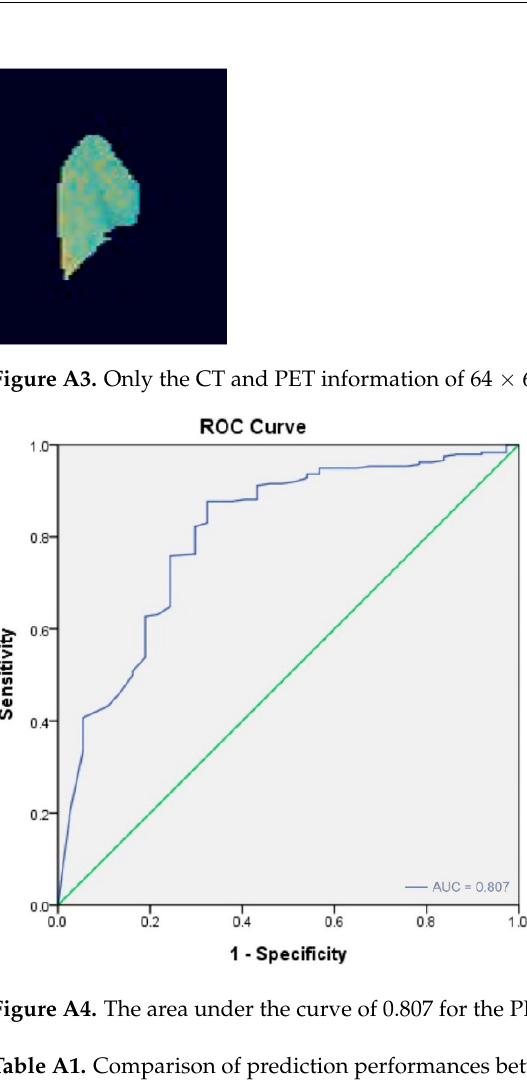
Figure A2. The liver 3D range is marked for training.